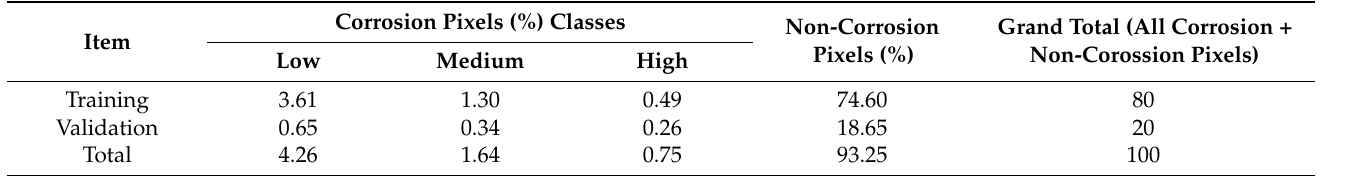
Table 1. The percentages of pixels in images used for model training and